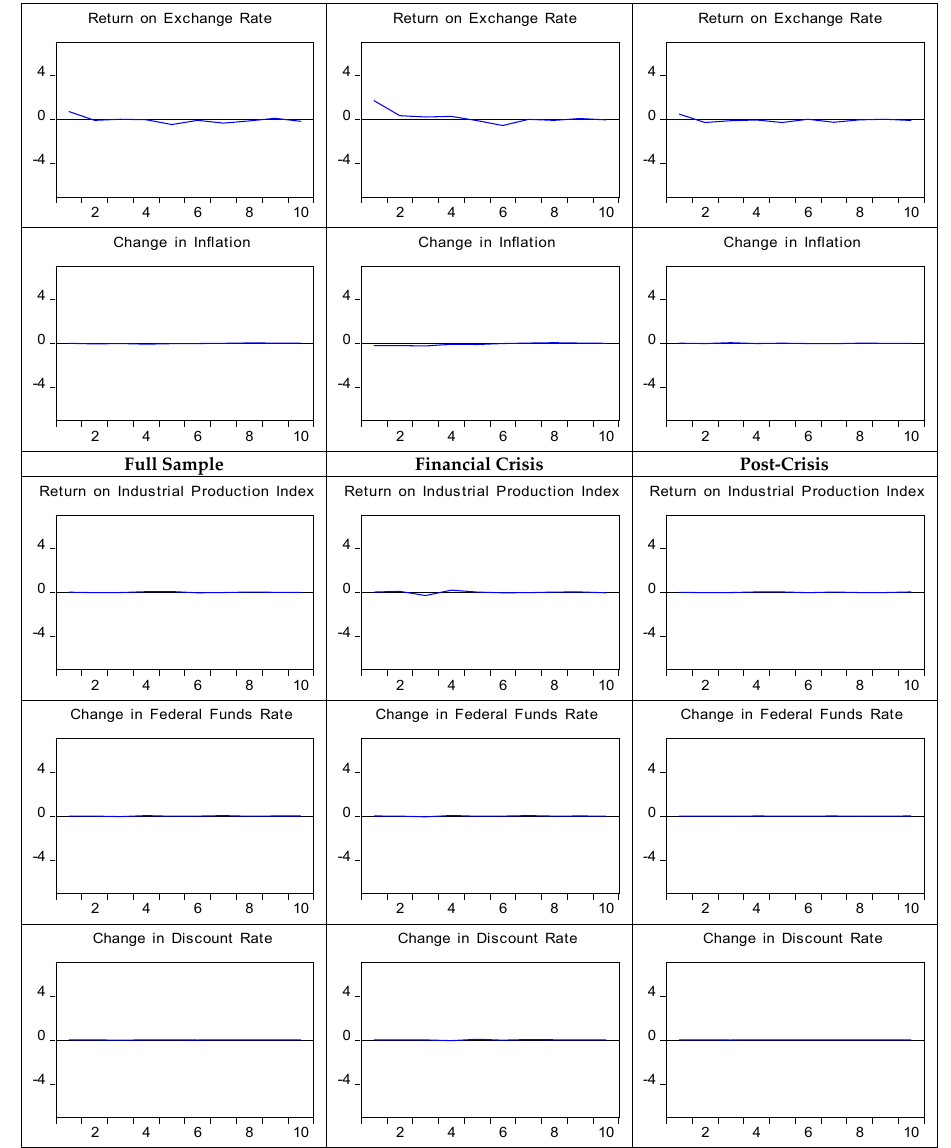
Figure 4. Impulse response functions for the response of illiquidity premiums to shocks in oil price returns, OVX returns, S&P 500 returns, returns on exchange rate, change in inflation, returns on industrial production index, change in federal funds rate and change in discount rate. This includes the full sample from May 2007 to December 2018 and sub-samples titled financial crisis (December 2007 to June 2009) and post-crisis (July 2009 to December The S&P500 index has a significantly negative relationship with illiquidity premiums both during and after the financial crisis. This is consistent with the rationale put forward by Eleswarapu and Reinganum (1993) and Elfakhani (2000), who argue that illiquidity premiums are a result of the size effect i.e., small firms are considered to be less liquid and thus should obtain higher return. A